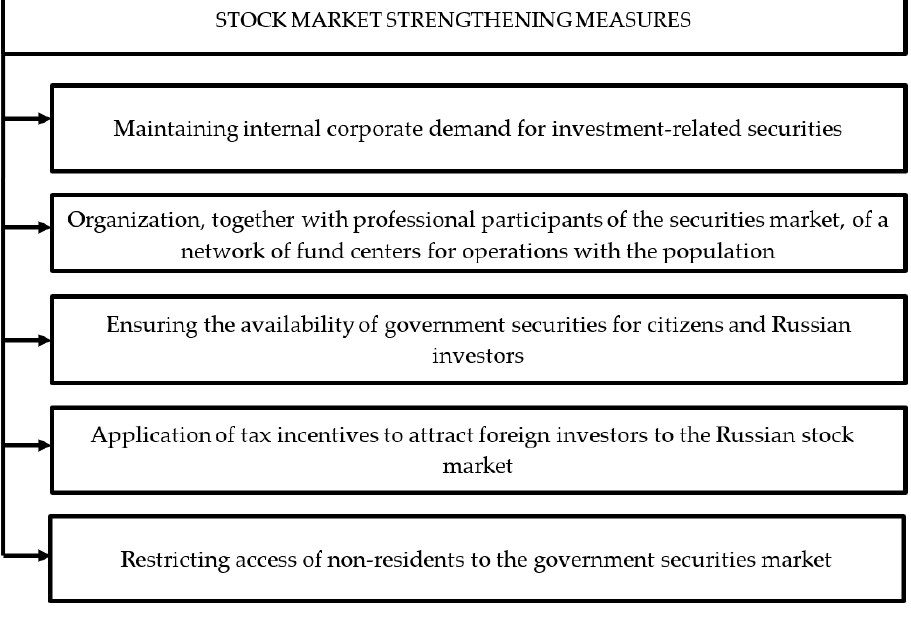
Figure 5. Measures to improve the performance of the stock market. Source: compiled by the au-